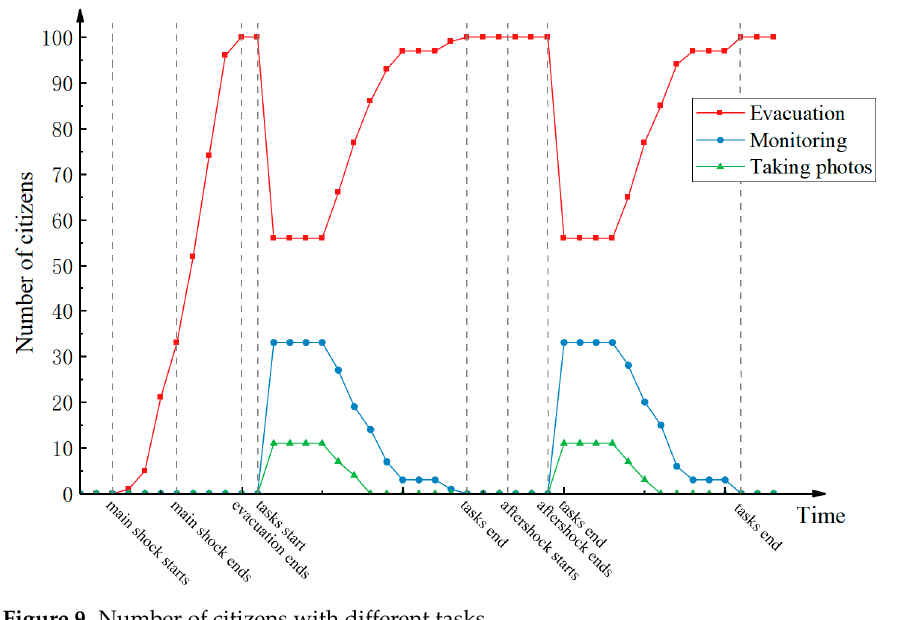
Figure 9. Number of citizens with different tasks.